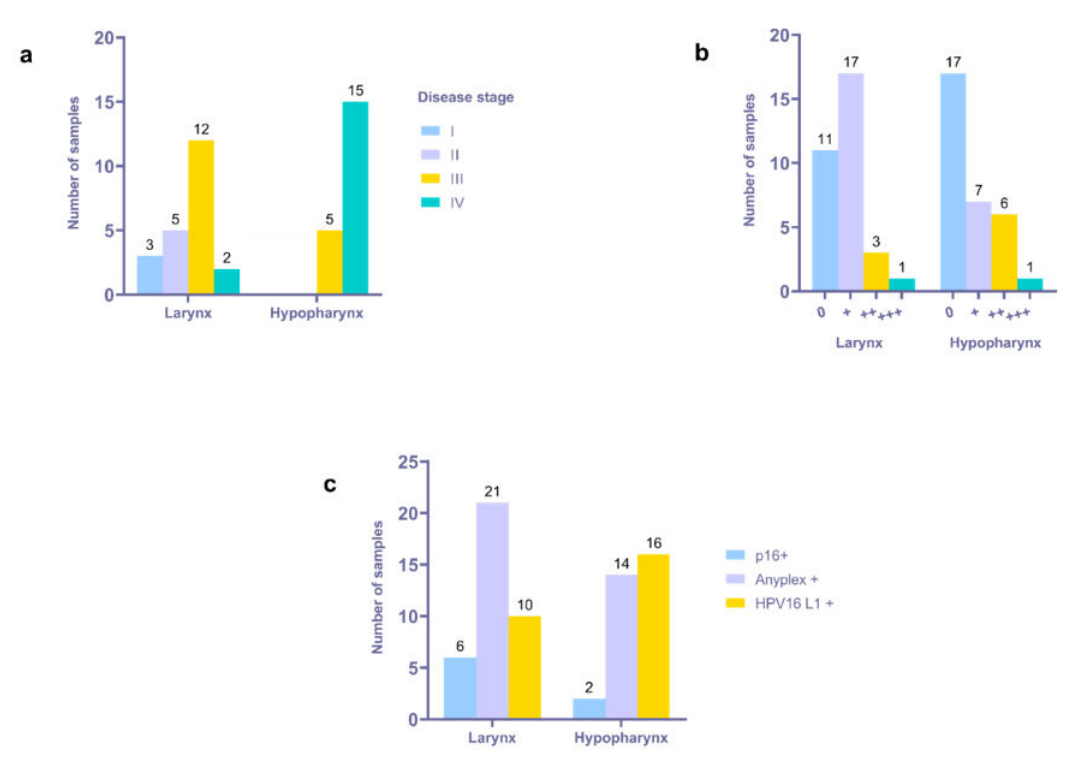
Figure 1. Distribution of HPV16+ tumor samples according to location, disease stage, and PCR data. ( a ) Distribution of HPV16+ tumor samples according to location and disease stage. ( b ) Distribution of HPV16+ samples according to location and Anyplex assay results; 0—negative, +—low viral load, ++—moderate viral load, +++—high viral load. ( c ) Cross-reference of p16 and HPV